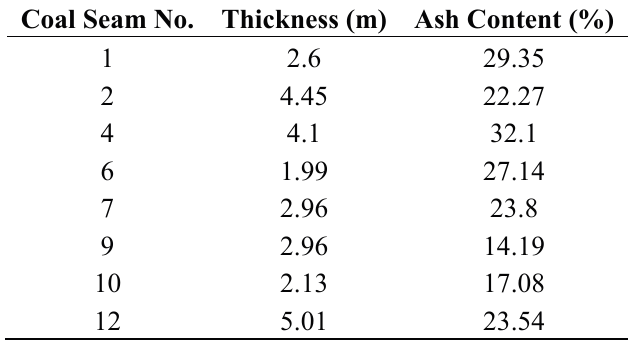
Table 3. Data from the fire-related coal seams in the Wuda coal field. Coal Seam